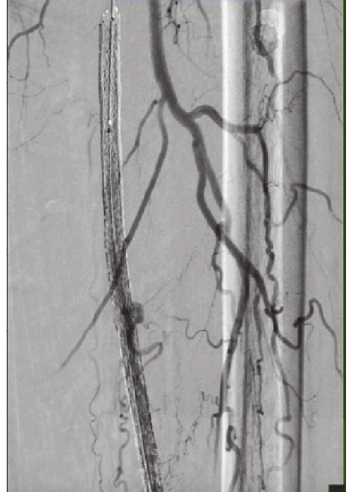
Figure 1: Totally occluded SFA.